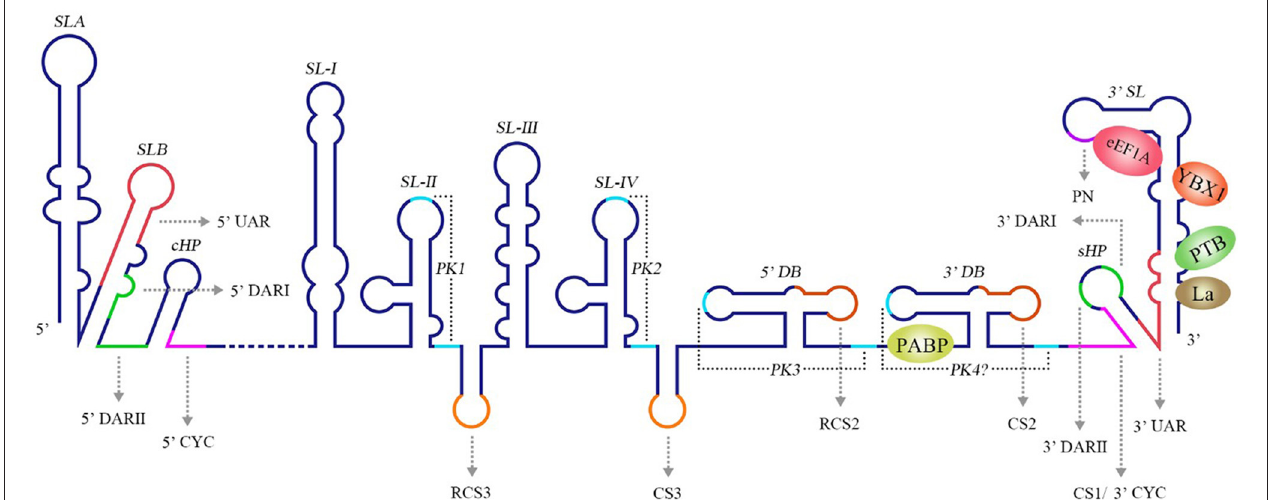
FIGURE 3 | Structure of the WNV genomic RNA. The arrows represent WNV circularization sequences and other conserved sequences, italics indicate higher order structures of the WNV RNA, and proteins that bind to WNV 3 ′ UTR are shown in ovals with different colors [reviewed in Bidet and Garcia-Blanco (2014)]. SL, Stem-loop; UAR, Upstream AUG region; DAR, Downstream AUG region; CYC, Cyclization sequence; cHP, Capsid hairpin; sHP, Small hairpin structure; RCS, Repeat conserved sequence; PK, Pseudoknot; DB, Dumbbell; PN, 5 ′ -CACAG-3 ′ pentanucleotide; eEF1A, Eukaryotic elongation factor 1A; YBX1, Y box-binding protein-1; PABP, Poly(A)-binding protein; PTB, Polypyrimidine tract-binding protein.